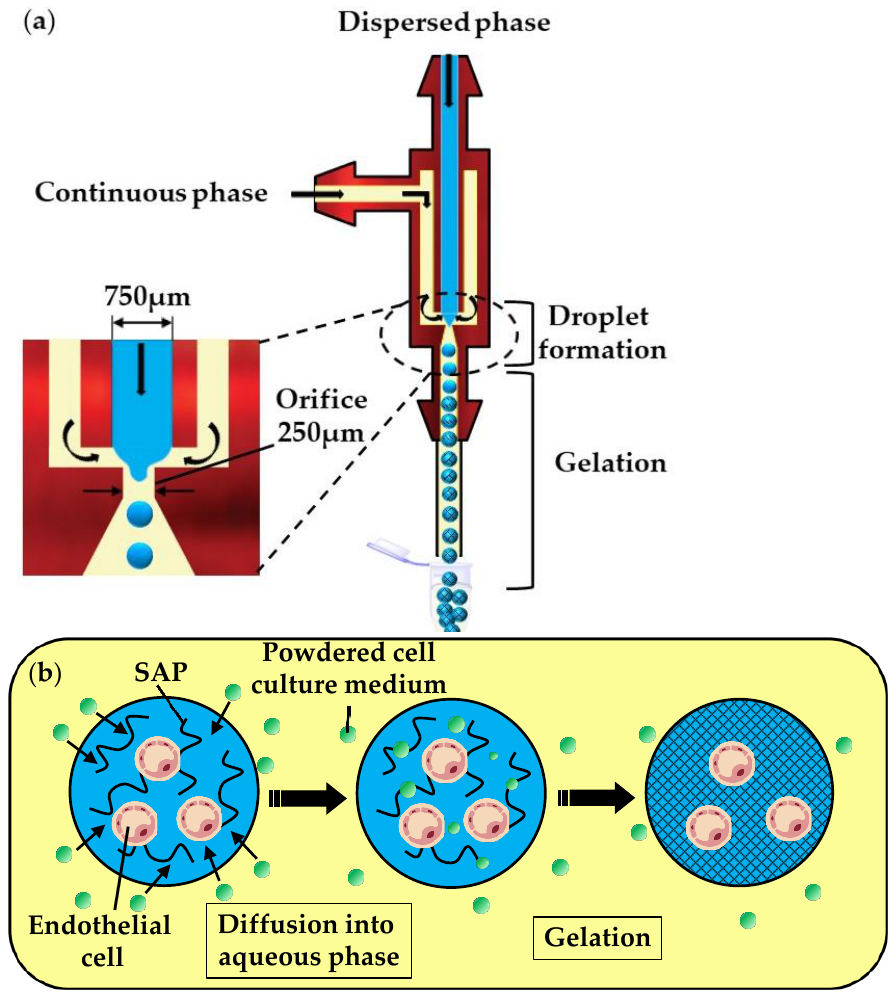
Figure 10. Production of self-assembling peptide (SAP) microgels loaded with bovine carotid artery endothelial cells by external gelation using a powdered cell culture medium dispersed in mineral oil. ( a ) Formation of droplets of cell-laden SAP solution. ( b ) Gelation of droplets due to an increase in the ionic strength caused by the diffusion of a powdered cell culture medium into droplets [50].